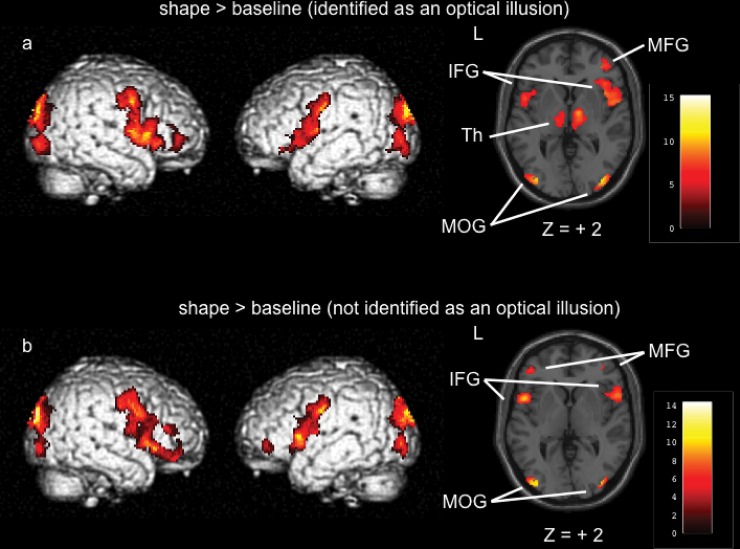
The four analyzed models having different matrix A structures (a).For details, see the “Materials and Methods” section. Results of Bayesian model selection of the random effects design on the model levels. Model expected probability (b) and model exceedance probability (c). p = pulvinar.